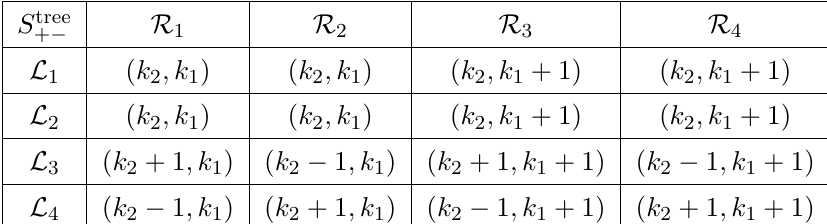
Table 5 . ( k L ; k R ) in all regions for the con(cid:12)guration S + (cid:0) .